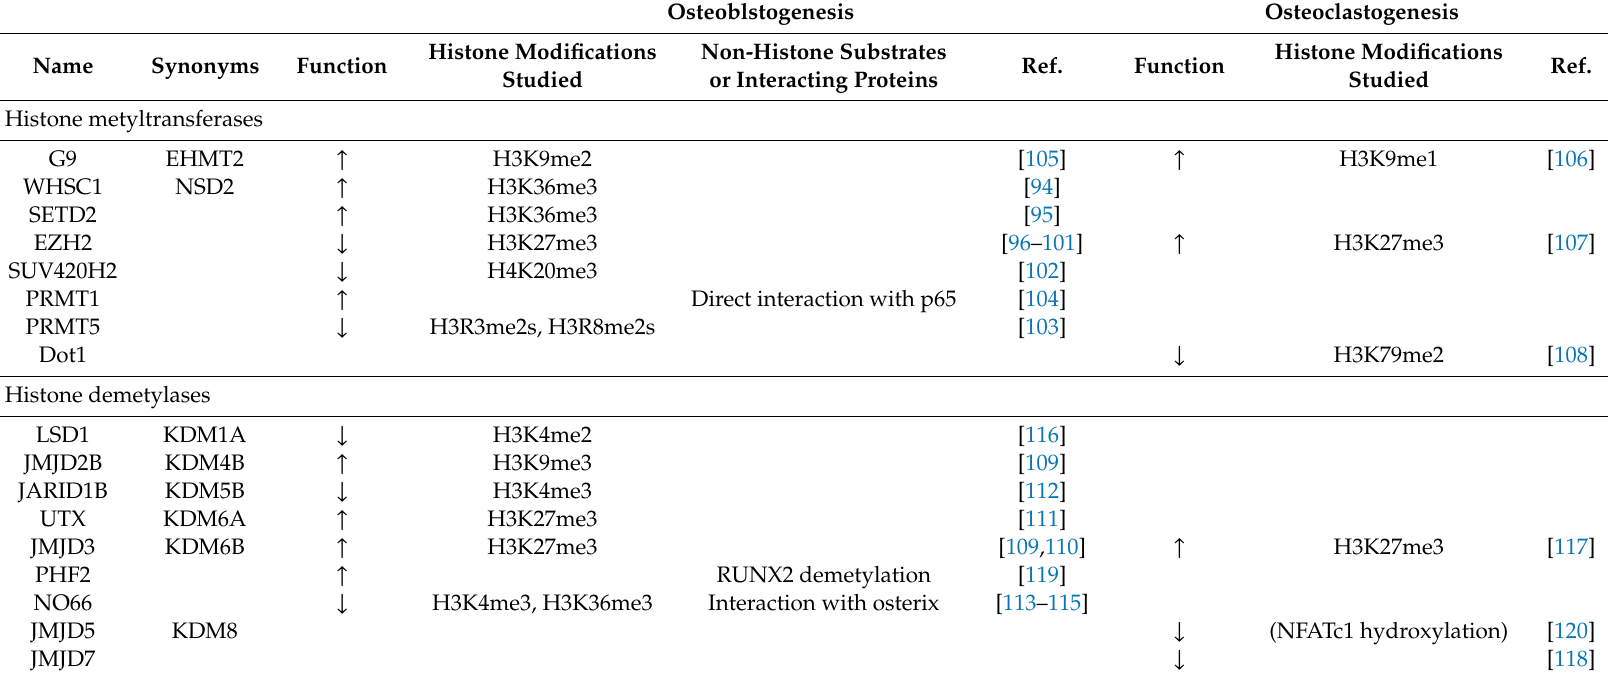
Table 2. Role of histone methyltransferase and demethylase on bone cell